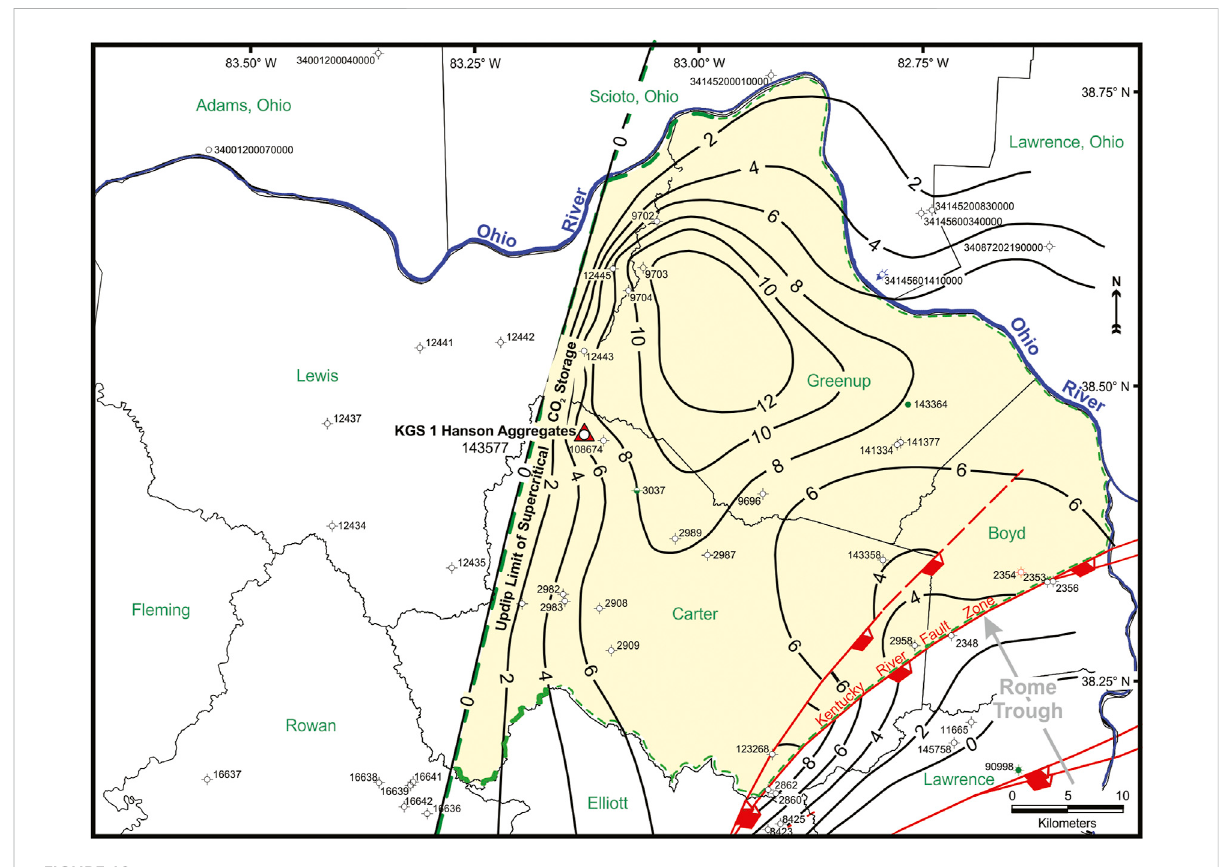
FIGURE 10 Isopach thickness contours of the netRose Run storage reservoir in theevaluation area at7% porosity cutoff. Average net reservoir thickness in the 2145-km 2 area is 6.2 m, and average porosity in the Rose Run reservoir ≥ 7% is